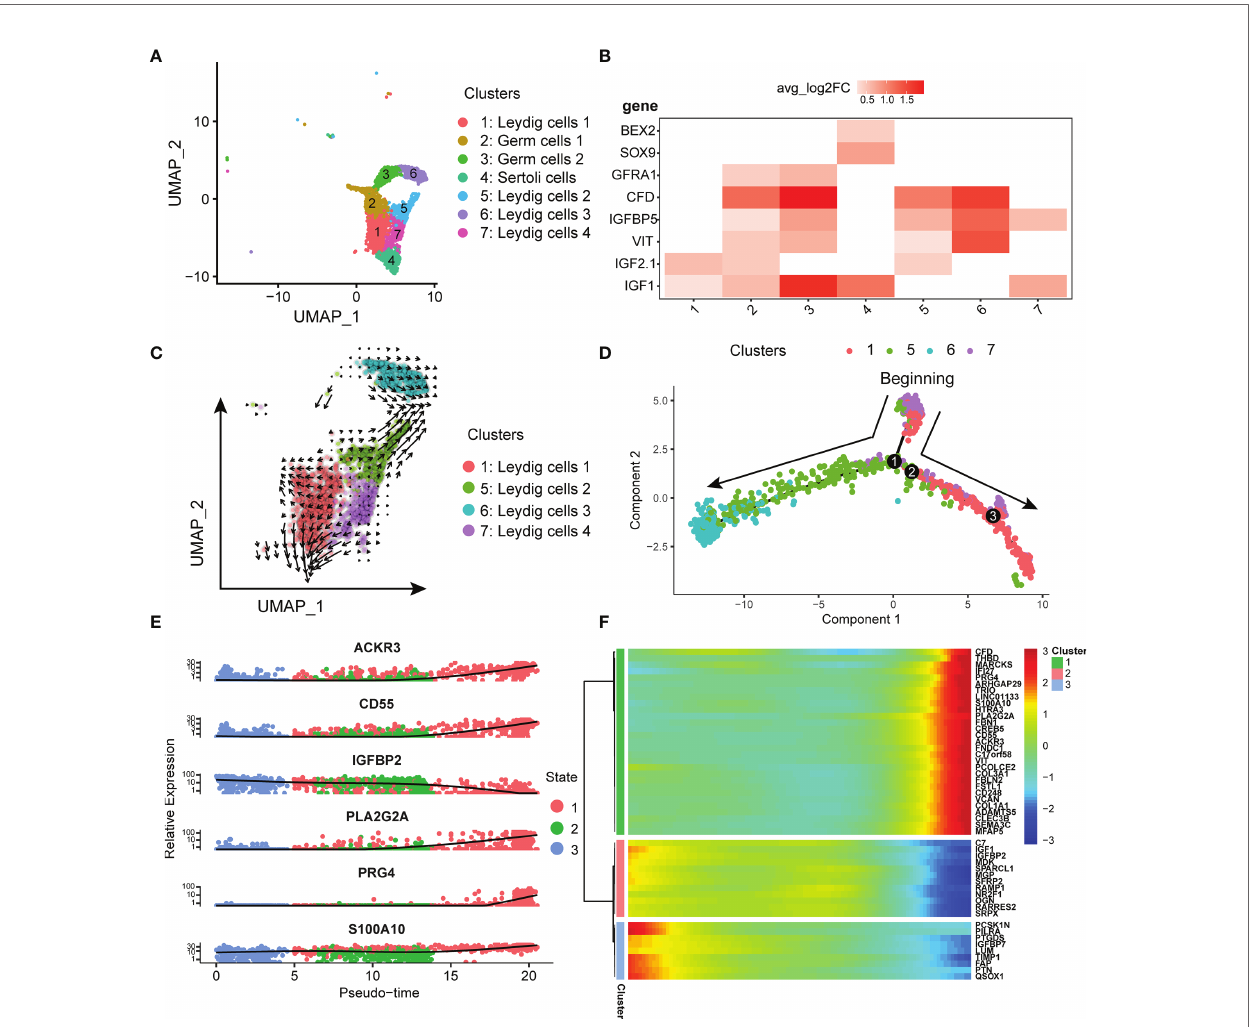
FIGURE 4 | (A) UMAP plot of germ, Leydig and Sertoli cells in testicular tumor. (B) Markers of Leydig, germ and Sertoli cells in testicular tumor; avg_log2FC, average log2 fold change. (C) Pseudotime analysis of Leydigcells byusing RNA velocity reconstructed the developmental lineages (arrows represent average velocity). (D) Reconstruction of the cellfate decisionsand pseudo-time trajectories of Leydig cells in testicular tumor byMonocle2. (E) Scatter plots showing the expression levelsand changes inrelative expression of key genes that affectedthe evolution stage. (F) Heatmap showing the top50 genes that in fl uenced the